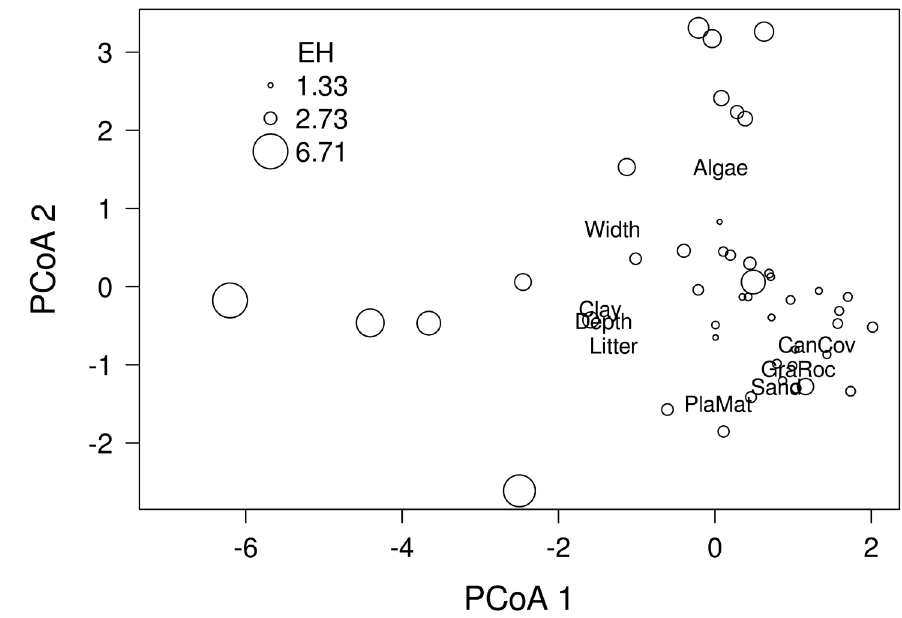
FIGURE 2 | Principal Coordinate Analysis (PCoA) of local environmental variables of streams from the urban area of Cuiabá, Mato Grosso, midwestern Brazil. The symbol sizes are proportional to the environmental heterogeneity (EH); PlaMat: plant matter; GraRoc: gravel and rocks; CanCov: canopy